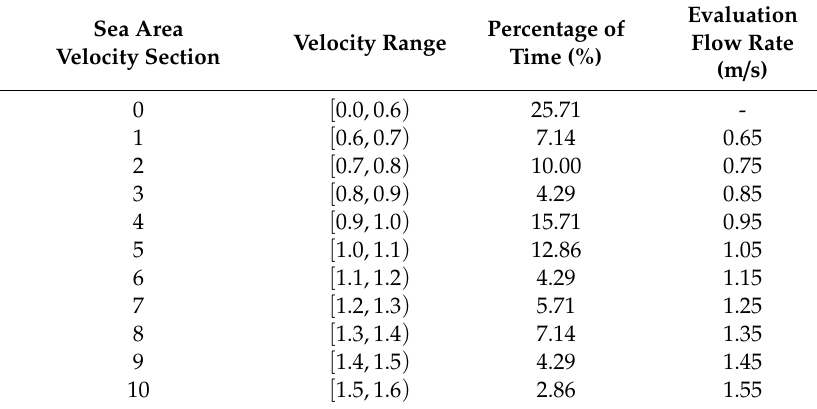
Table 5. Results of segmentation of experimental sea area velocity.